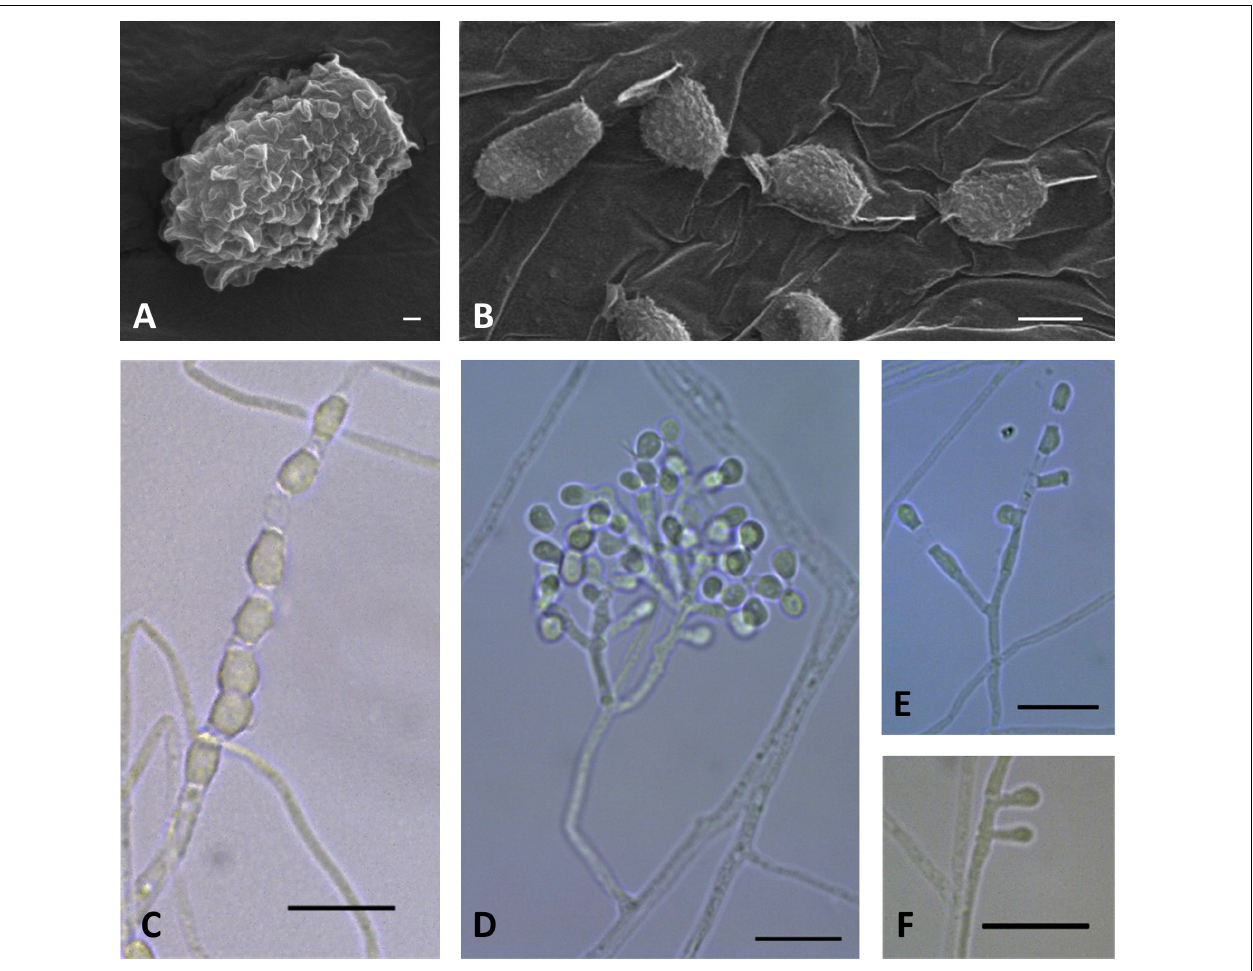
FIGURE 7 | Microscopic analysis of Pseudogymnoascus griseus sp. nov. Conidium (A) ; Chain of arthroconidia (B,C) ; Conidiophore (D) ; Fertile hyphae bearing arthroconidia and aleurioconidia sessile or stalked (E) ; Lonely stalked aleurioconidia (F) . In panels (A,B) , the structures were observed using transmission electron microscopy, while in panels (C–F) , light microscopy was used. Scale bars = 200 nm (A) , 2 µ m (B) , and 10 µ m (C–F) .